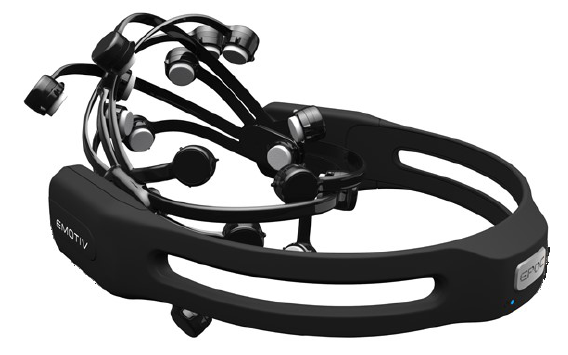
Fig. 5. Emotiv EPOC+ headset [19].